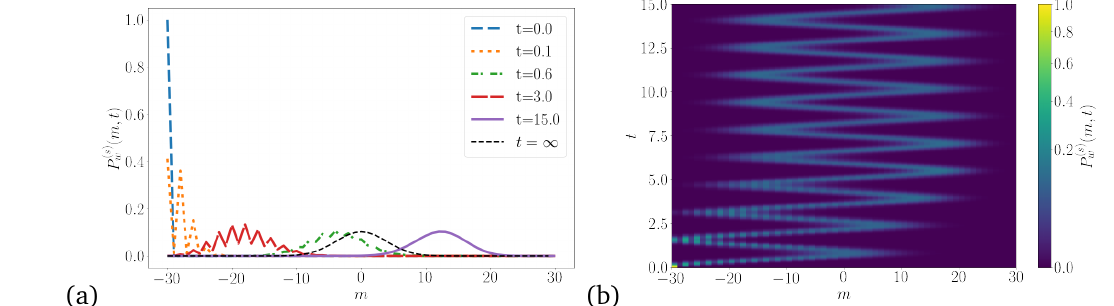
( m , t ) for a subsystem of size (cid:96) = 60 at times t = 0,1.4,30.0 for a Figure 16: P ( s ) w system initialized in a Néel state and time evolved with H ( h = 0.2 ) . The dotted lines are the asymptotic probability distributions given in (70).